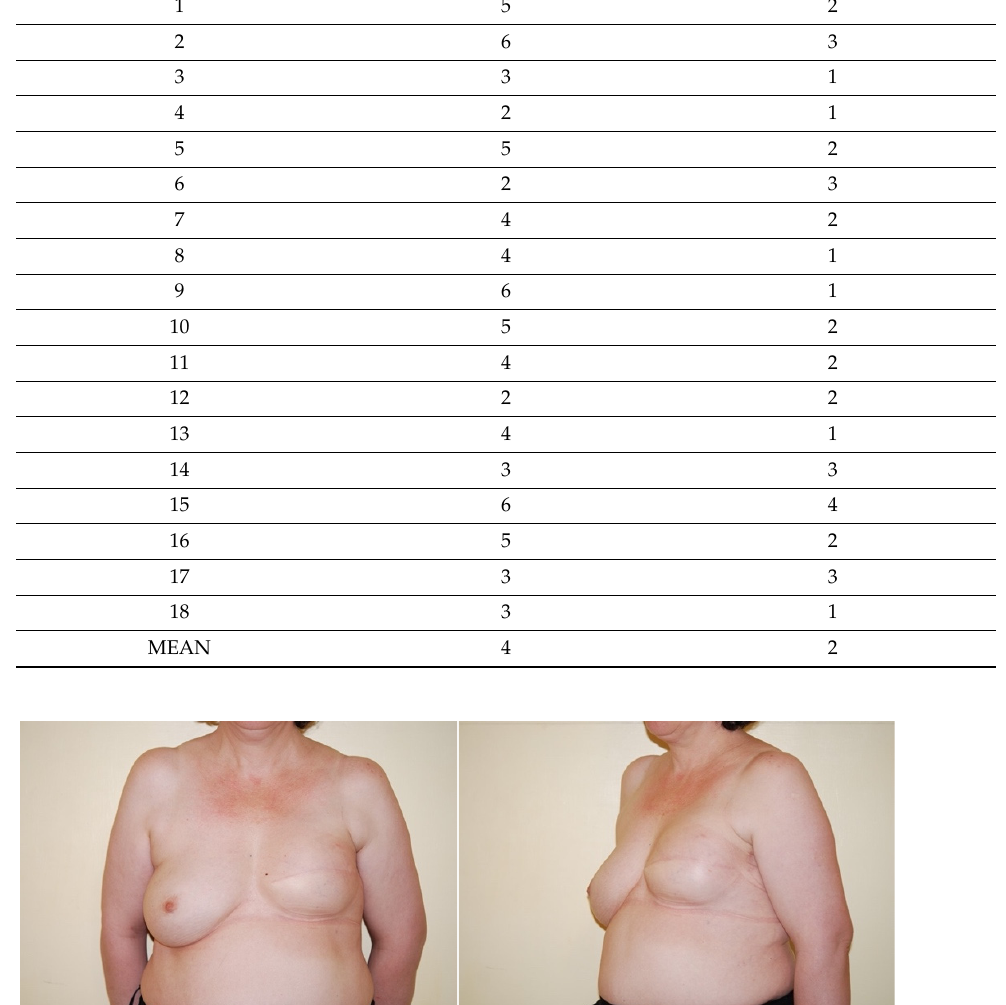
Table 3. VAS pain measurement: values of VAS the first and the third day after surgery. Pain Intensity after Surgery on the VAS Scale